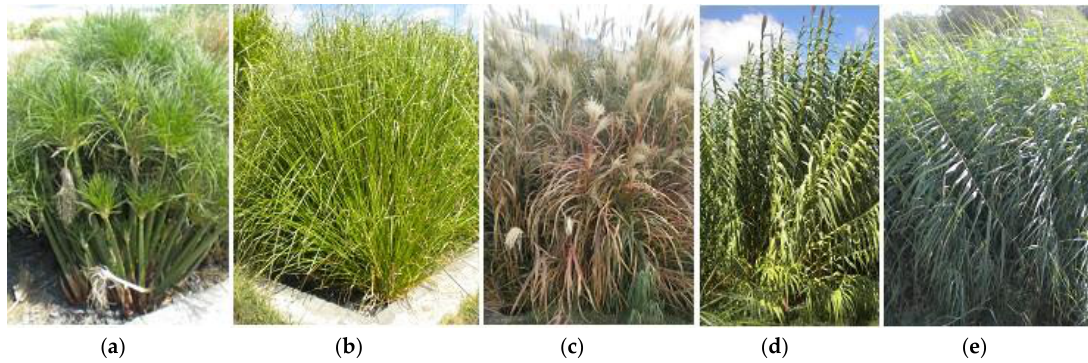
Figure 2. Pictures of Cyperu papyrus ( a ), Chrysopogon zizanioides ( b ), Miscanthus x giganteus ( c ), Arundo donax ( d ), and Phragmites australis ( e ).